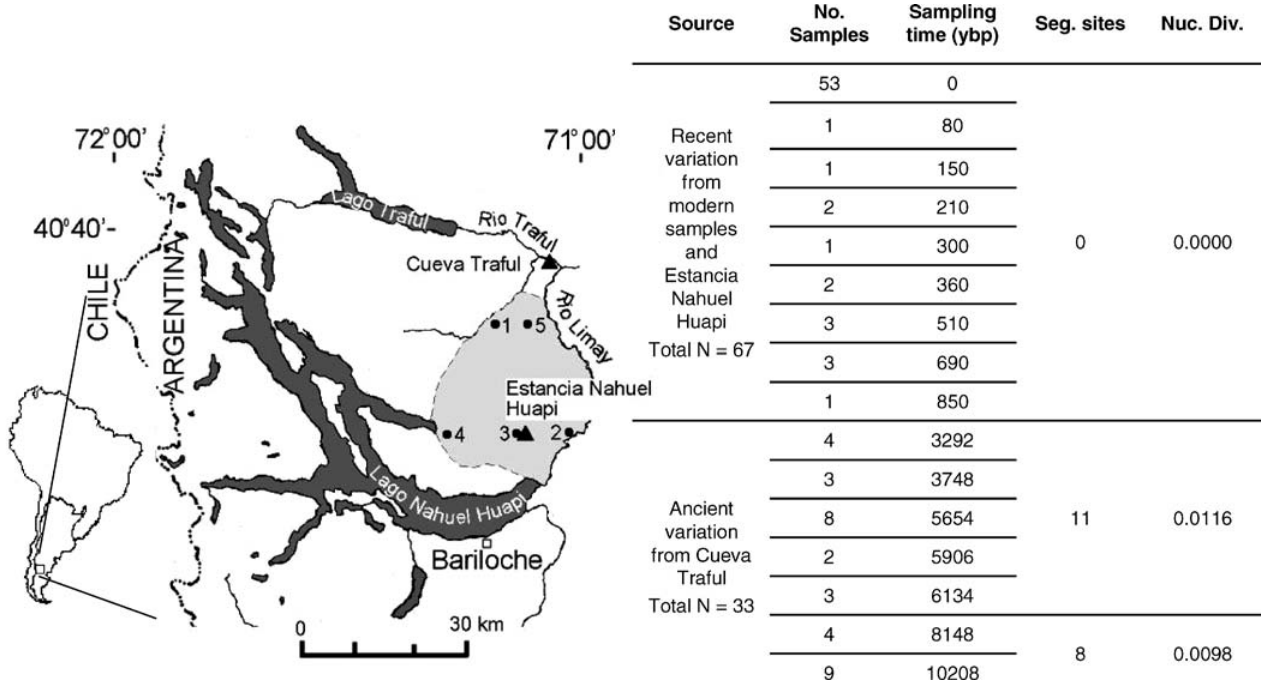
Figure 4. Map of Sampling Sites and Modern Range of C. sociabilis with Table of Temporal Sampling Listed are number of samples per sampling time and observed values for segregating sites and nucleotide diversity used in the bottleneck model. Numbers on map indicate locations of modern populations [8]. DOI: